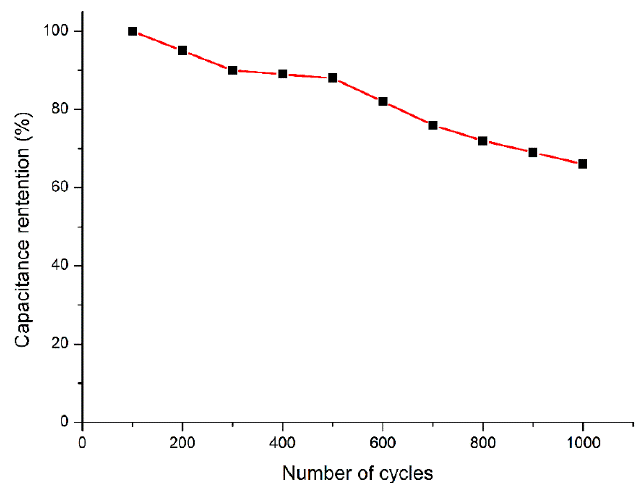
Figure 8. Cycle performance of the Ni@Cu-MOF-based asymmetric supercapacitor at a current density of 1 A g.